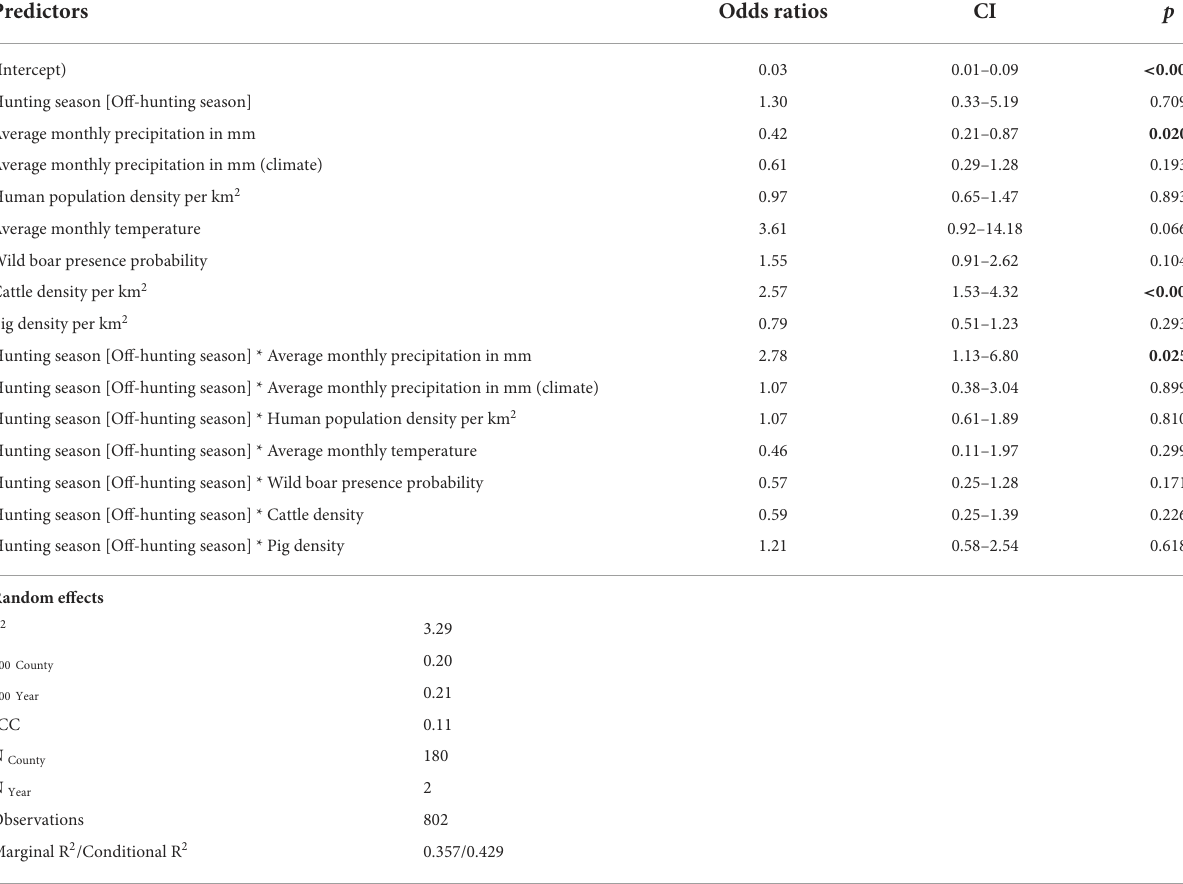
TABLE 2 Estimates of fixed effects influencing the presence of ESBL/AmpC E. coli in wild boar ( Sus scrofa L. ) with the county as random effect (significance threshold p < 0.05).